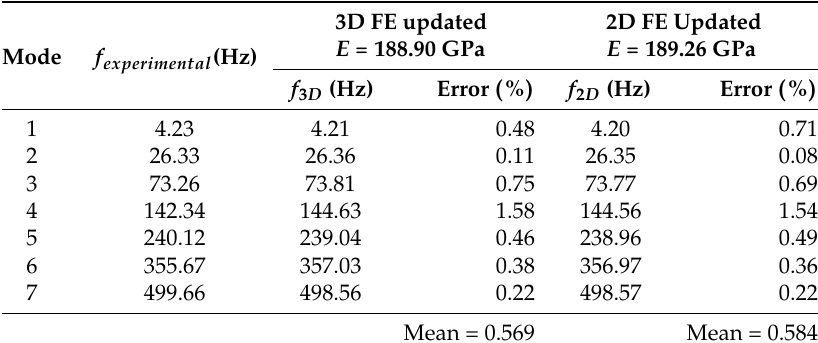
Table 2. Eigenfrequencies of healthy cantilever